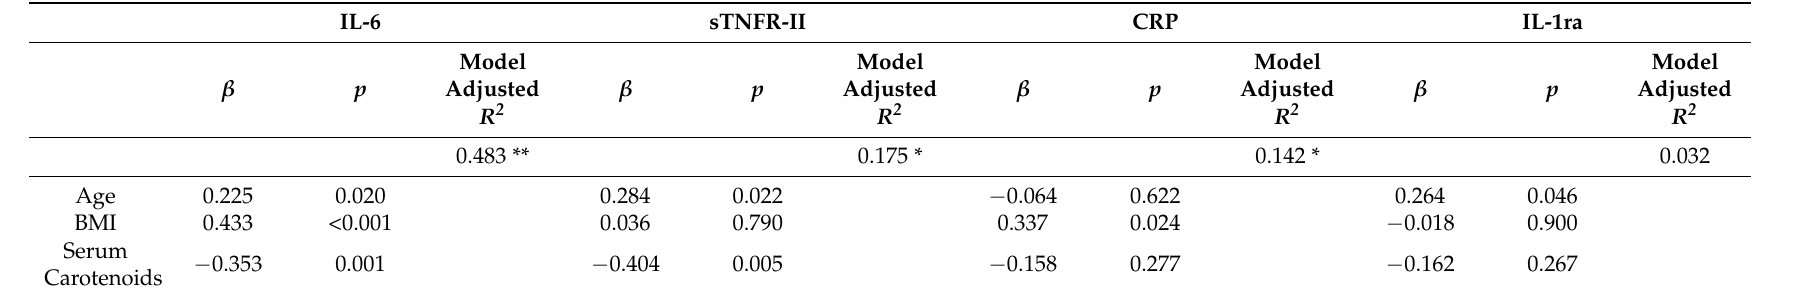
Table 6. Regression analyses explaining variability in inflammatory